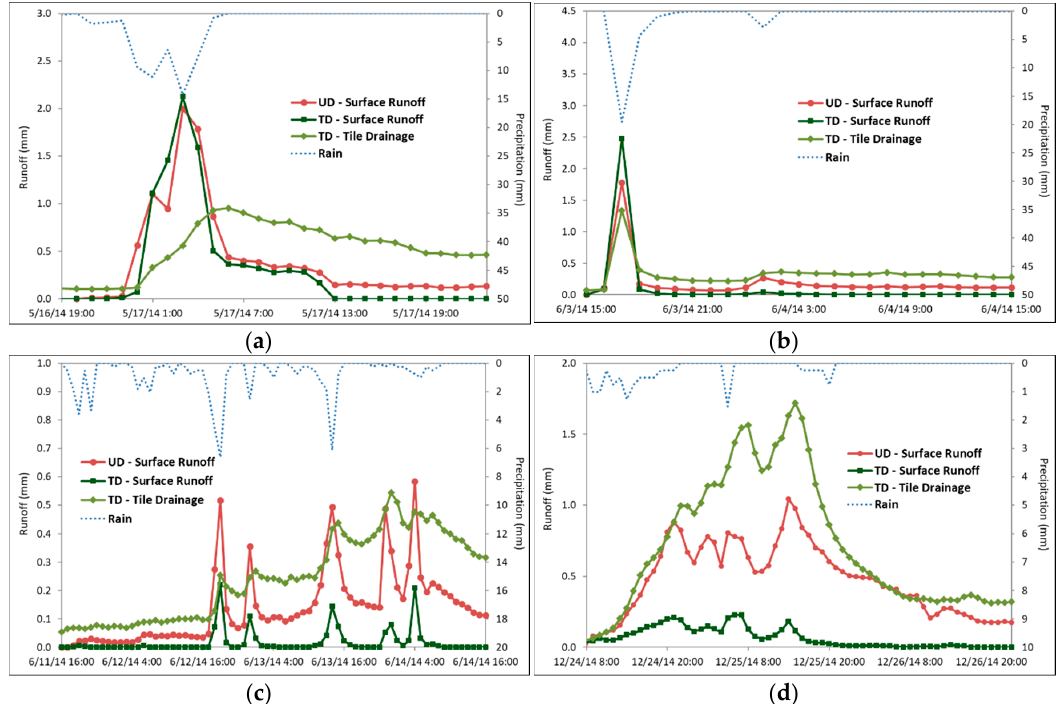
Figure 3. Precipitation and mean runoff by hydrologic pathway for the tile-drained (TD) and undrained (UD) plots for four runoff events beginning on ( a ) 16 May 2014; ( b ) 3 June 2014; ( c ) 11 June 2014; and ( d ) 24 December 2014.